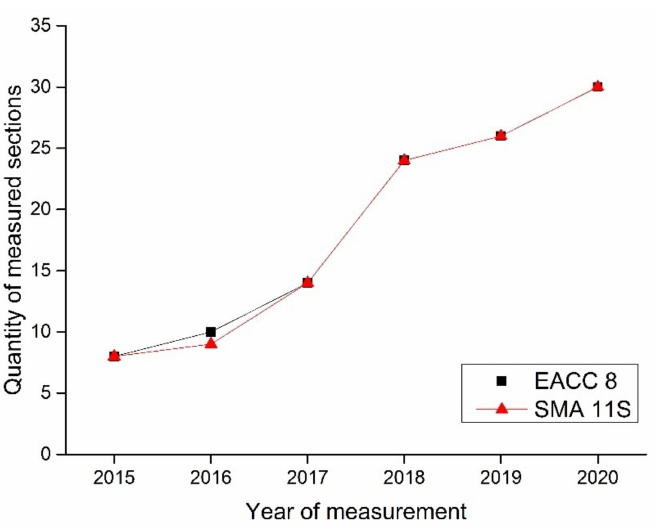
Figure 5. Number of measured sections within the framework of the monitored sections of motorway in individual years.